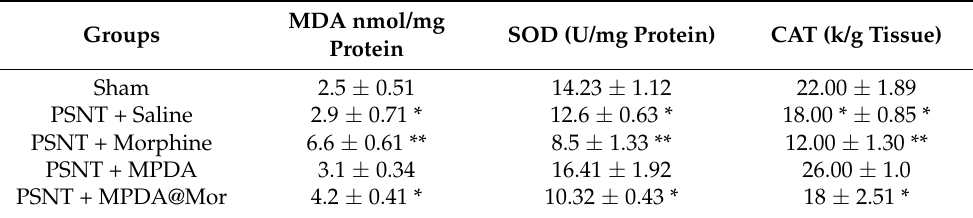
Table 2. Effects of morphine, MPDA@Mor on lipid peroxidation and antioxidant enzyme levels in Sham and PSNT rat